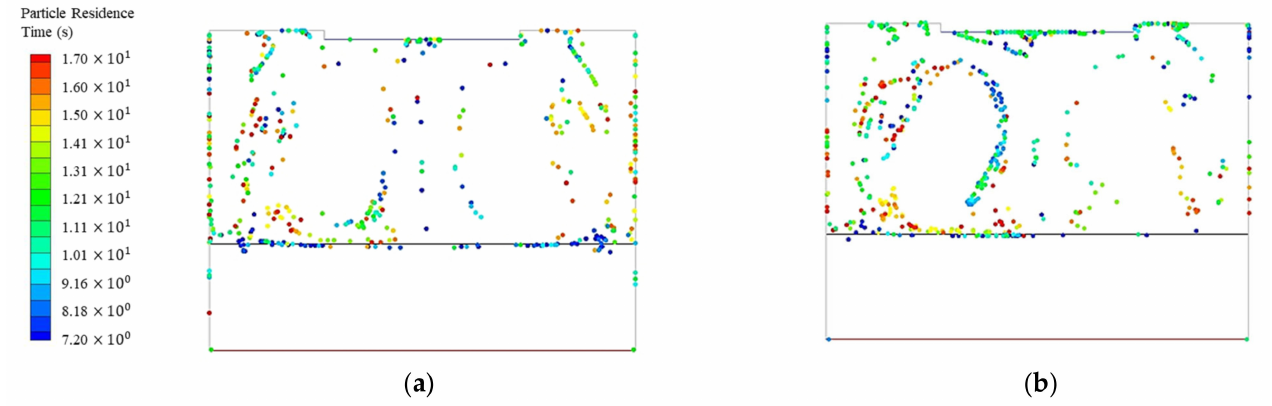
Figure 15. 50 µ m inclusions distribution with different types ( a ) MnO and ( b ) Al 2 O 3 .